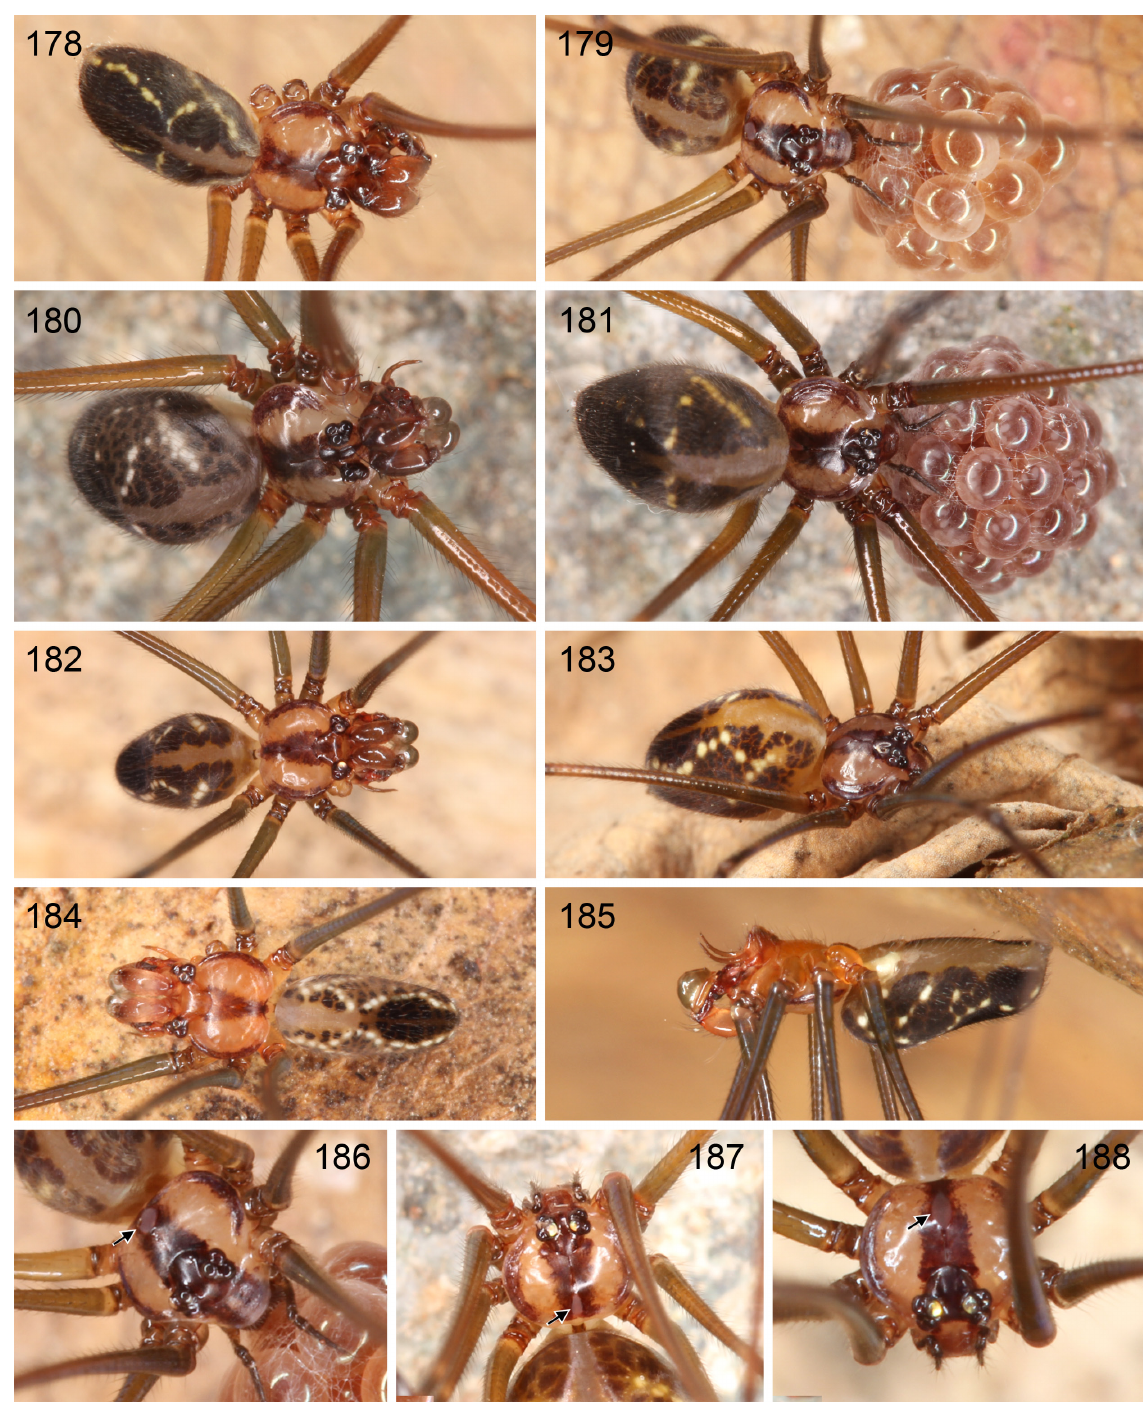
Figs 178–188. Live specimens. Aetana omayan group. — 178–179 . A. abadae Huber, sp. nov., ♂ and ♀ with eggsac from Twin Lakes, Negros. — 180–181 . A. omayan Huber, 2005, ♂ and ♀ with eggsac from Baguio, Luzon. — 182–183 . A. manansalai Huber, sp. nov., ♂ and ♀ from Mt. Banahaw, Luzon. — 184–185 . A. lozadae Huber, sp. nov., ♂♂ from Mt. Isarog, Luzon. — 186–188 . Female prosomata, showing stridulatory plates (arrows), in A. abadae Huber, sp. nov. (186), A. omayan Huber, 2005 (187) and A. manansalai Huber, sp. nov.